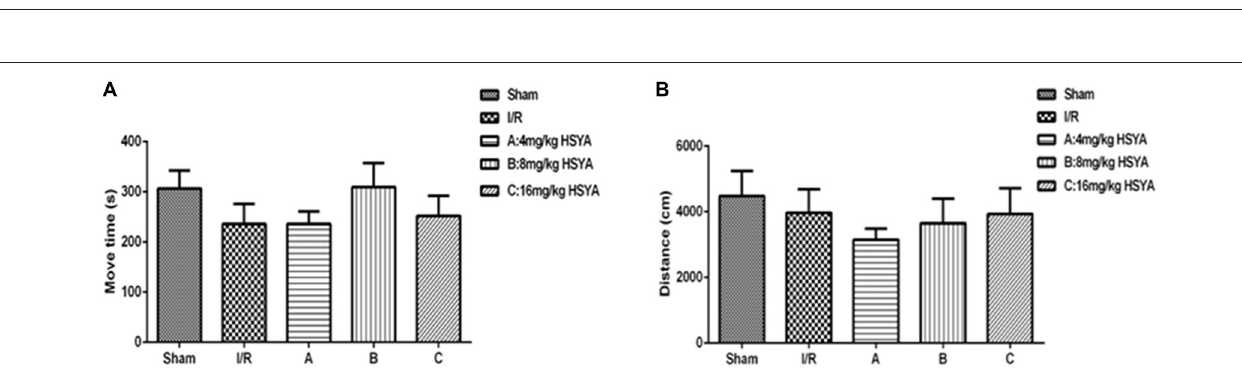
FIGURE 1 | Middle cerebral artery occlusion (MCAO) model was evaluated to be suitable for studying the pharmacology efficacy of Hydroxysafflor yellow A (HSYA). (A) Neurological scores, (B) brain edema, (C) infarct volume, (D) pictures of infarct volume. The values are shown as means ± SEM. Significant difference between sham group vs. MCAO group in neurological scores (sham, n = 8; MCAO, n = 8, ∗∗∗∗ P < 0.0001), brain edema (sham, n = 2; MCAO, n = 6, ∗∗ P < 0.01) and infarct volume (sham, n = 2; MCAO, n = 8, ∗∗∗∗ P < 0.0001).